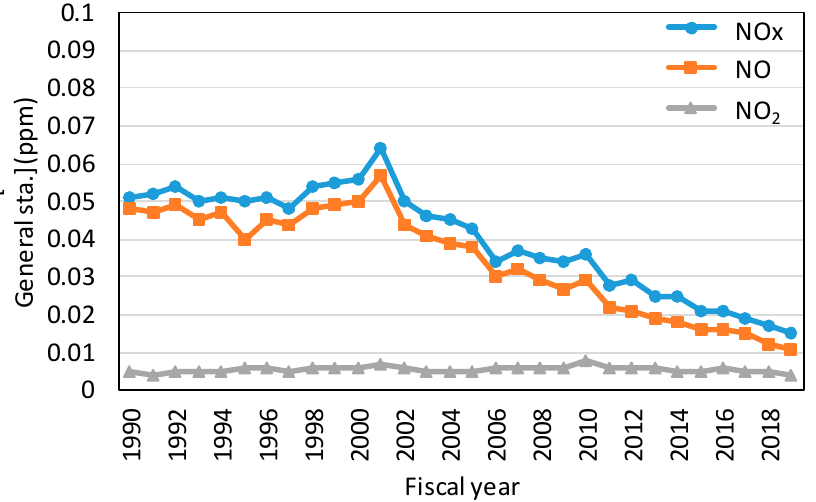
Figure 20. Trend in the average of NOx, NO 2 , and NO at Roadside sta. in the nighttime during the cold season. NOx, NO 2 , and NO: same as Figure 19.